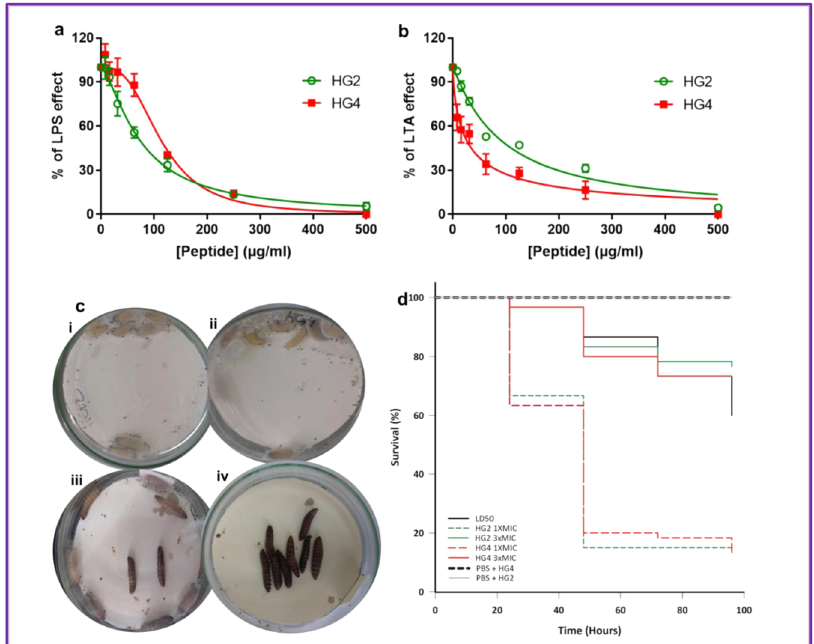
Fig. 8 Peptide anti-in fl ammatory activity in murine macrophages and in vivo ef fi cacy assessment in G. mellonella MRSA infection model. Inhibitory action of HG2 and HG4 on LPS or LTA-driven in fl ammation in murine macrophages: eLUCidate ™ Raw 264.7 NF-kB reporter cell line was used to measure the inhibitory action of HG2 and HG4 on LPS ( a ) or LTA ( b ) -mediated in fl ammation as explained in the Materials and Methods ’ section. Data were plotted using GraphPad ® Prism 7 software. Results are expressed as means ± standard deviation. Representative images of toxicity assay of peptides ( c ) — ( i ) HG2 and ( ii ) HG4 in G. mellonella 120 h post-treatment with 3x MIC concentrations. The larvae remained alive and without melanisation. Virulence assay of MRSA USA300 in G. mellonella using a lethal dose inoculum of 10 6 CFU/per larvae — ( iii ) 24 h post-infection: some larvae were dead and partial melanisation was observed. ( iv ). 48 h post-infection: most larvae were dead and complete melanisation was evident. The experiment was done with three experimental replicates, each containing groups of 10 larvae. d Kaplan – Meier survival curves of G. mellonella infected with a lethal dose (LD 50 ) of S. aureus (2.25 × 10 6 CFU/larvae) and treated with peptides HG2 and HG4 at 1x and 3x MIC concentrations and uninfected larvae treated with peptides in PBS at 3x MIC (placebo showing a 100% larvae survival